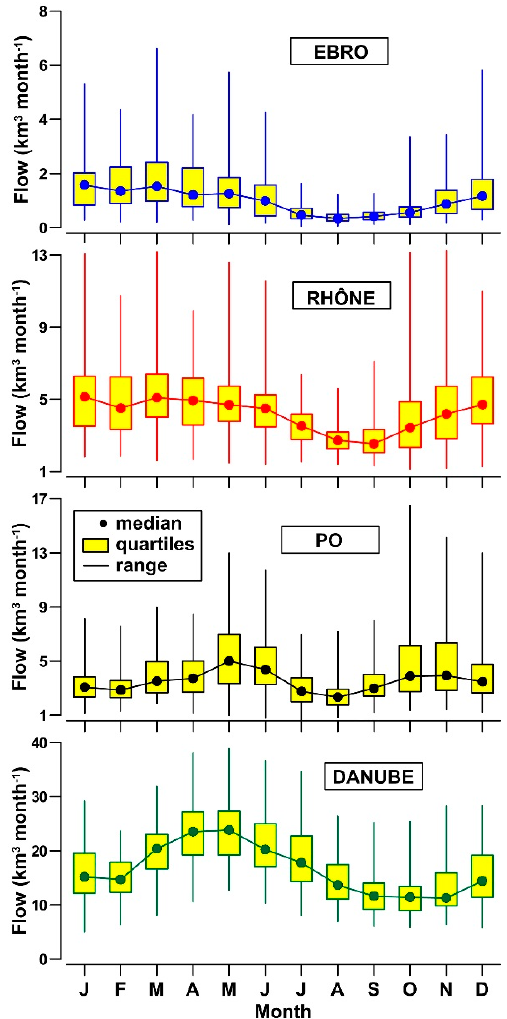
Figure 2. Box Whisker Plot (median, quartiles, data range) of monthly integrated river water discharge (km 3 month − 1 ).